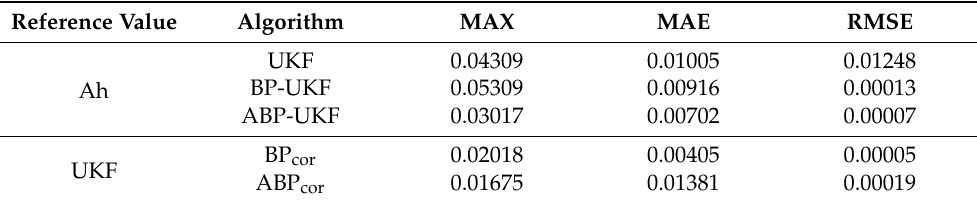
Table 2. Criteria for the SOC estimation results under HPPC working